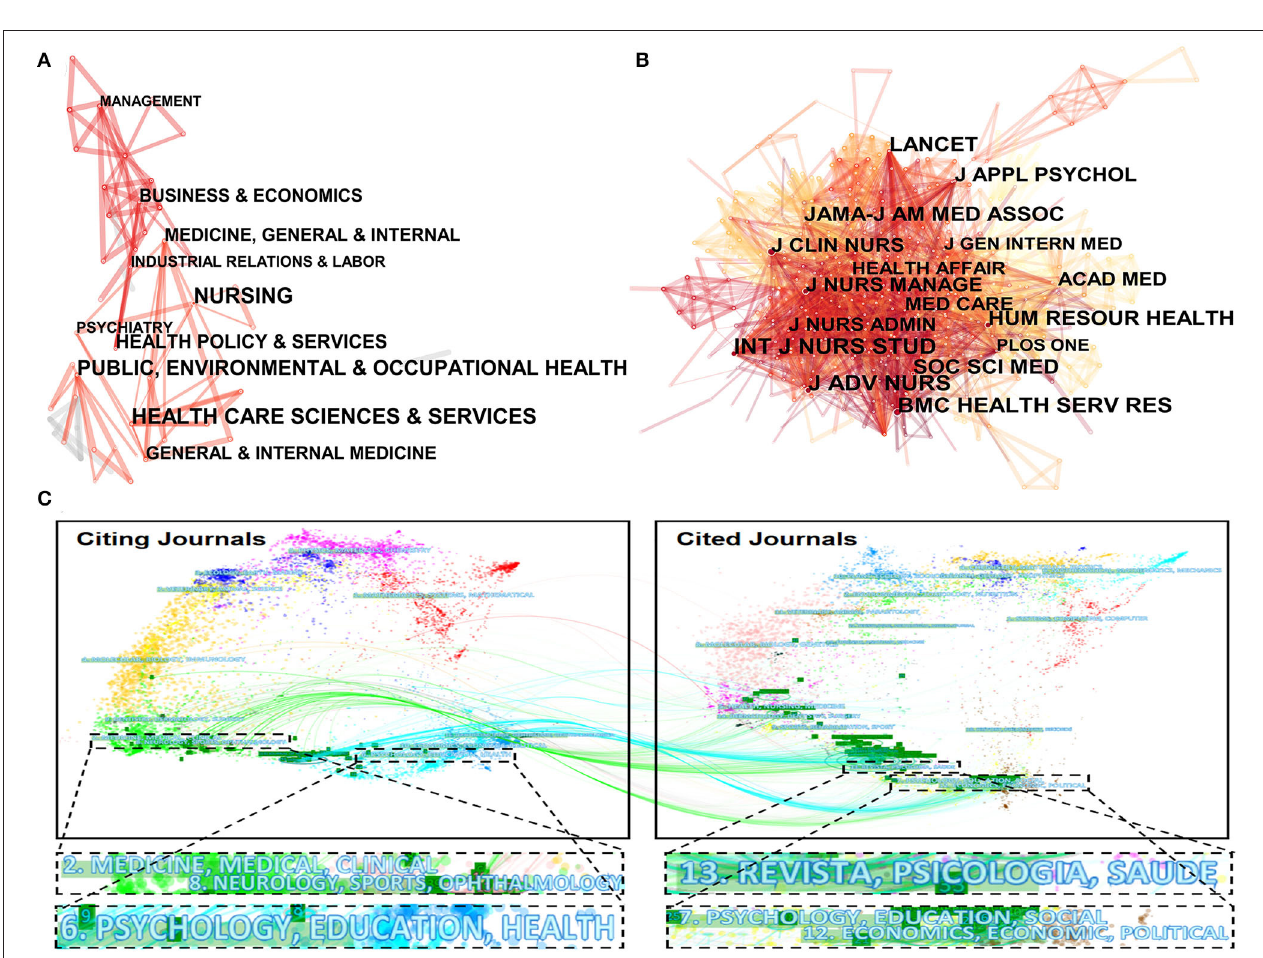
FIGURE 4 | Map of disciplines (A) , cited journals (B) , and dual-map overlay (C) of publications in the research field.